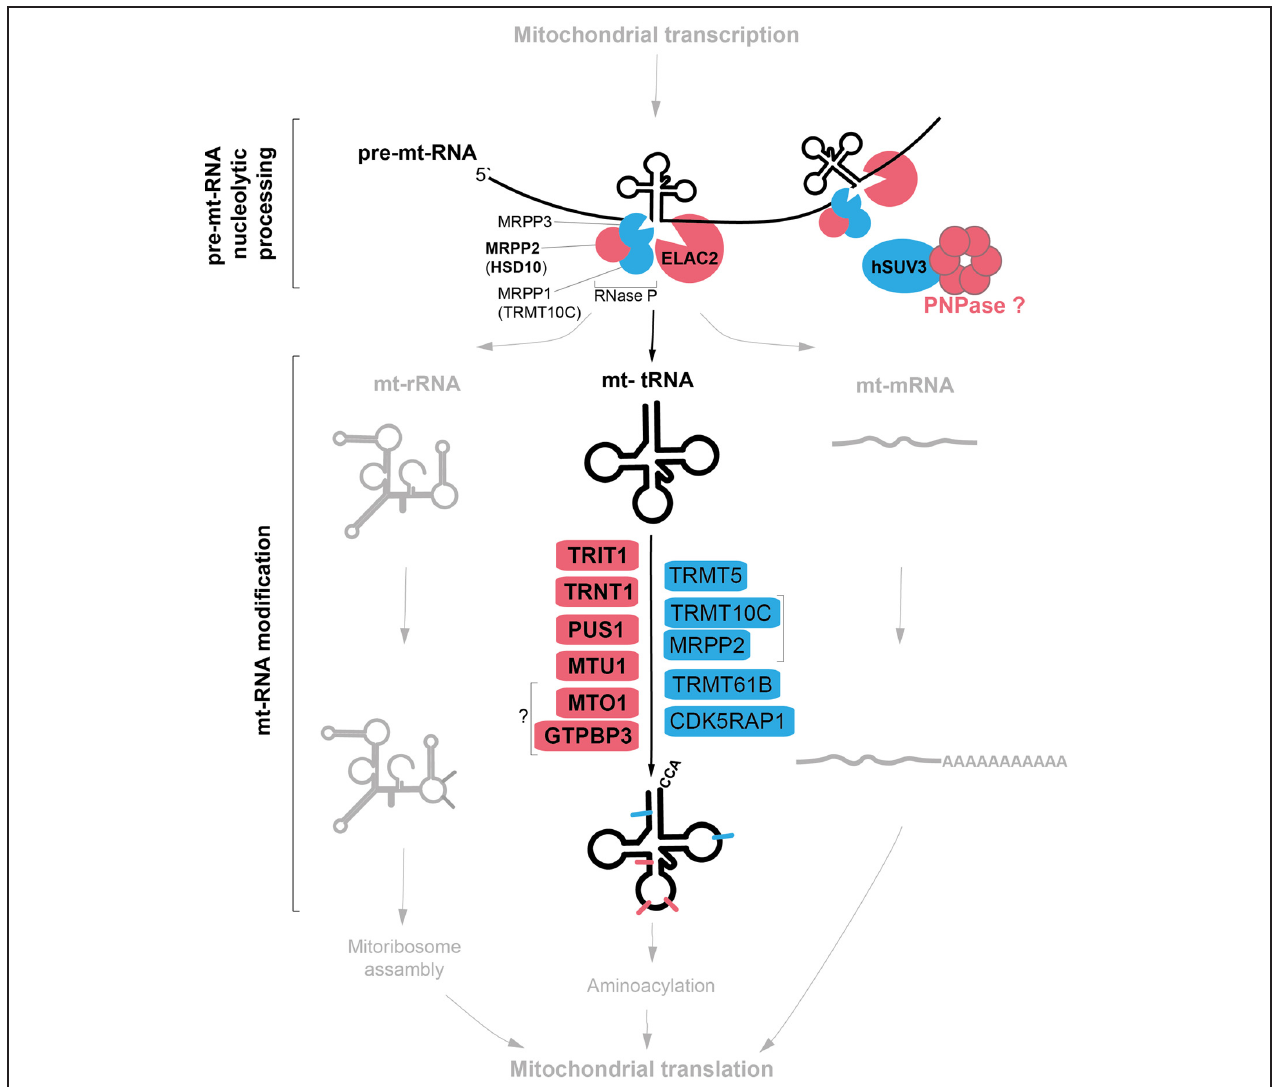
FIGURE 1 | Mitochondrial RNA maturation and factors involved. Key protein factors involved in post-transcriptional nucleolytic processing and in chemical modifications of mitochondrial tRNAs. Factors associated with human disease are indicated in red; other factors characterized thus far are in blue.